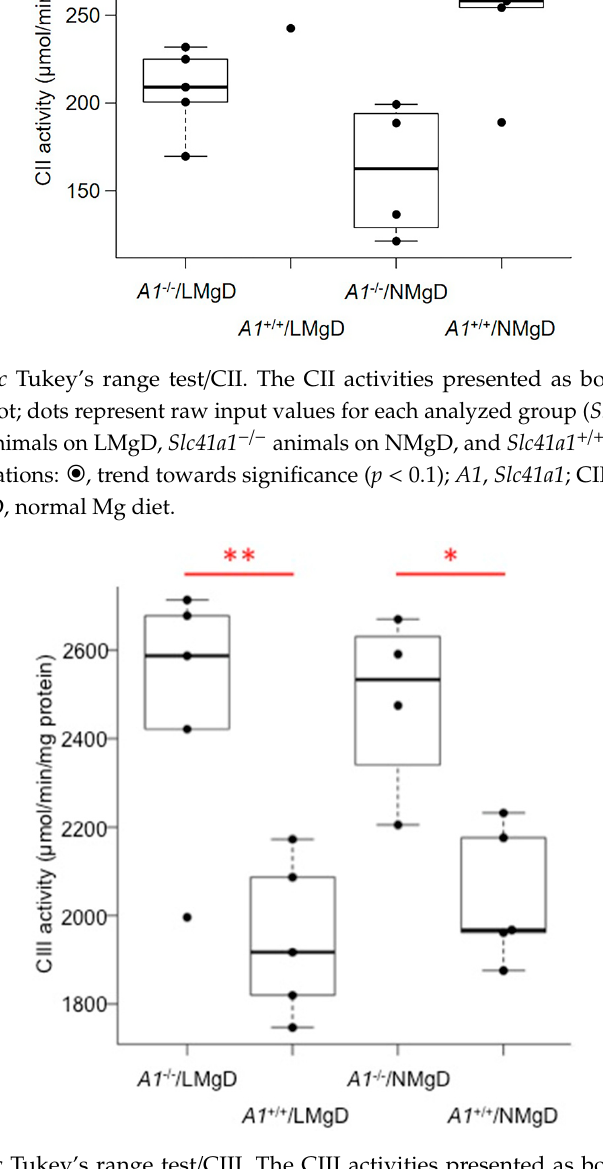
Figure A8. Post-hoc Tukey’s range test / CIII. The CIII activities presented as box-and-whisker plot overlaid with dot plot; dots represent raw input values for each analyzed group ( Slc41a1 − / − animals on LMgD, Slc41a1 +/+ animals on LMgD, Slc41a1 − / − animals on NMgD, and Slc41a1 +/+ animals on NMgD); * p < 0.05, ** p < 0.01. Abbreviations: A1 , Slc41a1 ; CIII, complex III; LMgD, low Mg diet; NMgD, normal Mg diet.